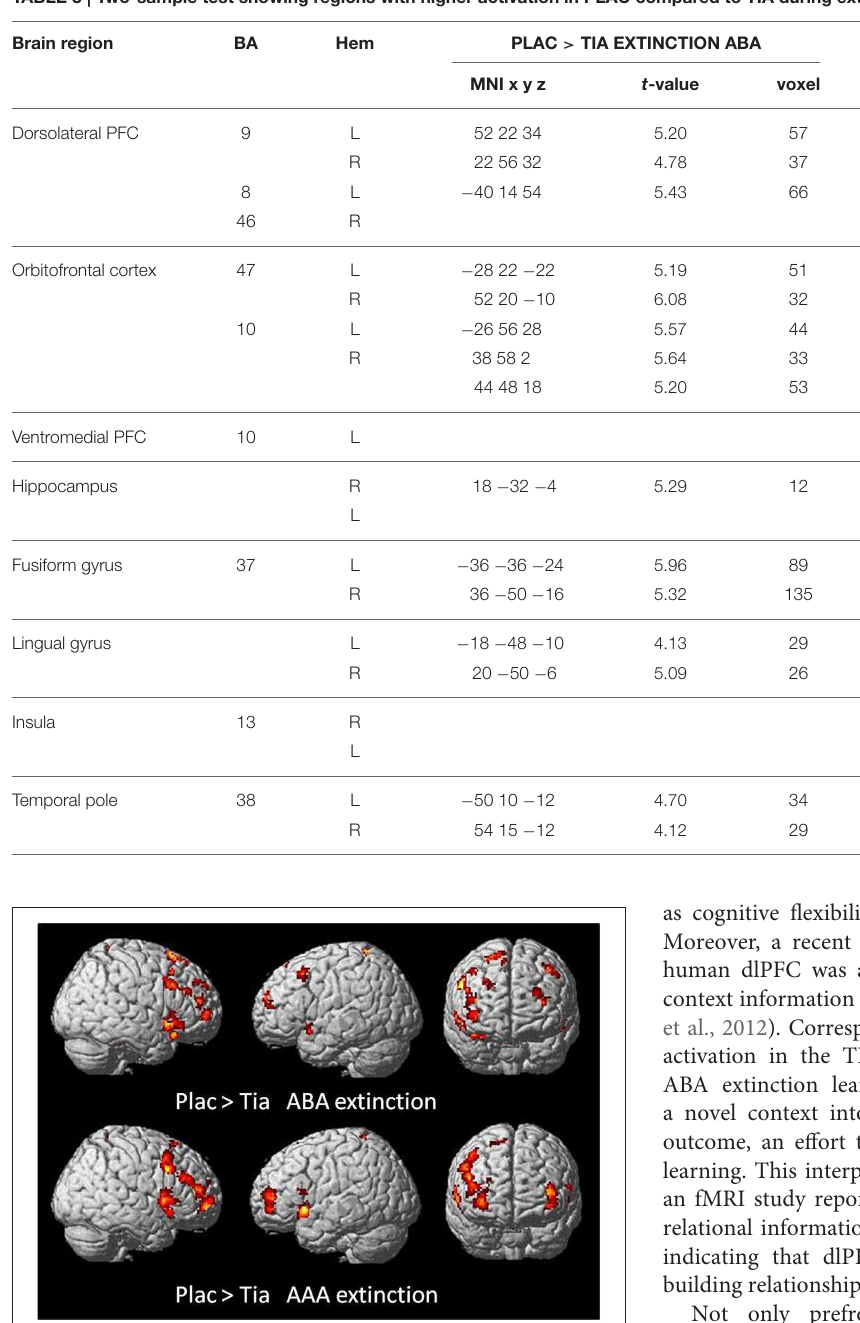
FIGURE 4 | Areas of reduced activation in the TIA group compared to the PLAC group in a two-sample t -test ( p < 0 . 05 FWE-corrected on cluster level, minimum cluster size k = 10 ) for ABA and AAA extinction. Activation in the TIA group is reduced predominantly in prefrontal regions, and also in further areas including hippocampus, insula and temporal